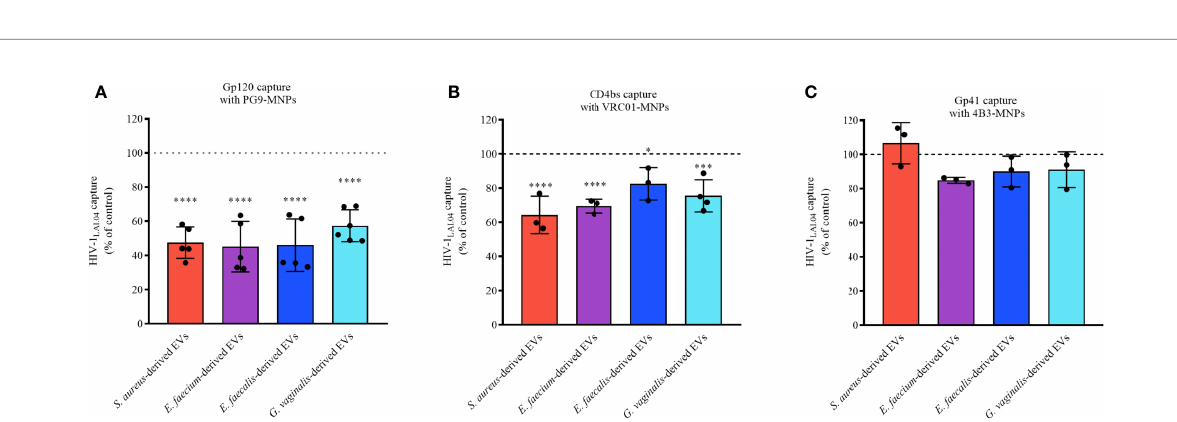
FIGURE 7 | HIV-1 capture. HIV-1 LAI.04 was pre-treated with 1×10 10 EVs derived from S. aureus , E. faecium , E. faecalis , or G. vaginalis , or with particles derived from MRS medium, or with PBS (control) for 1h. Next, HIV-1 LAI.04 virions were captured with PG9 (A) , VRC01 (B) , or 4B3 (C) antibodies coupled to magnetic nanoparticles (MNPs). PG9 antibody recognizes HIV-1 trimeric gp120 proteins, VRC01 recognizes the CD4 binding site on the viral gp120, and 4B3 antibodies recognize the viral gp41. Data are presented as percentage of p24 gag concentration compared with the control. Presented are means±SEM from three independent measurements. Asterisks indicate statistical signi fi cance by one-way ANOVA multiple comparison with Dunnett ’ s correction (*p < 0.05, ***p < 0.001,